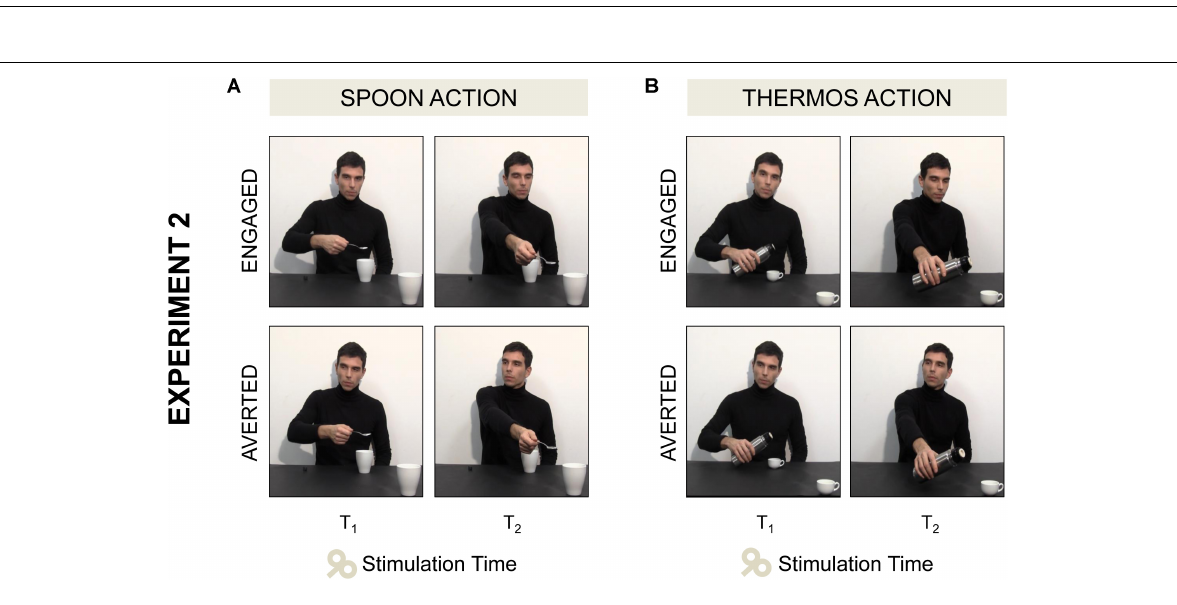
FIGURE 3 | Four video clips were adopted in Experiment 2. (A) In the Spoon-Engaged video the actor started stretching out his arm toward a mug out of his reach while directing his gaze toward the observer (T 1 , see the first frame), then he completed the request gesture while gazing at the mug (T 2 , see the second frame). (A) In the Spoon-Averted video the actor performed the very same “Spoon” action, but when stretching out his arm toward the out-of-reach mug he turned away his gaze pointing to his right. (B) In the Thermos-Engaged and Thermos-Averted videos the same action sequences were shown, except for the type of grasp (WHG) and the target object (coffee